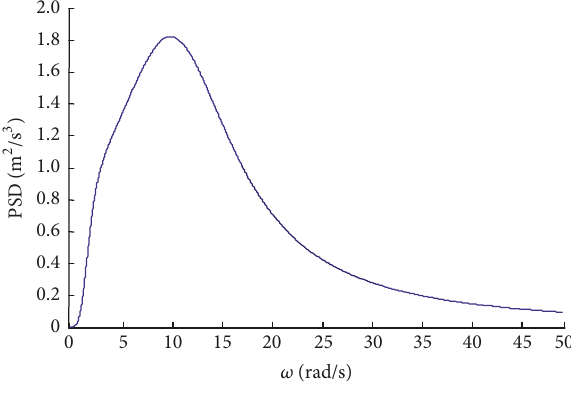
Figure 3: PSD of the earthquake input. Table 1: Modal analysis results of the bare building and of the retrofitted